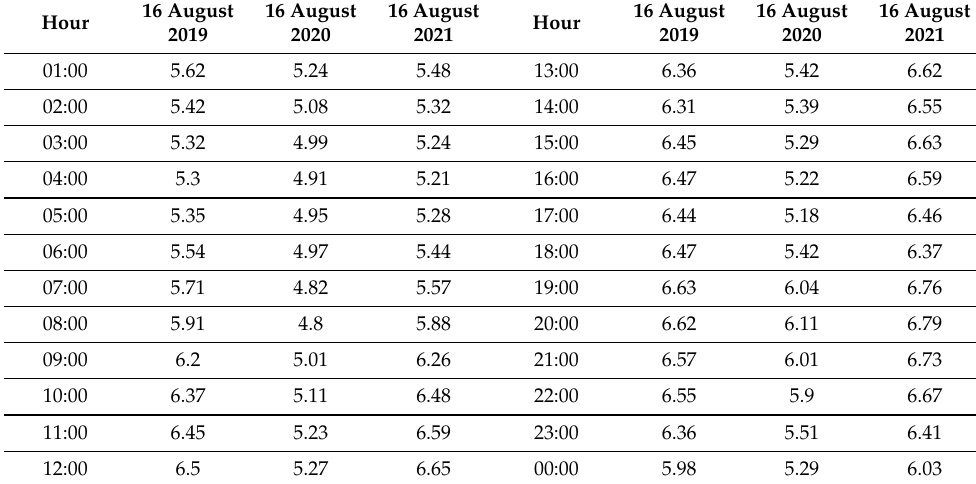
Table 7. SEIN demand (GW).